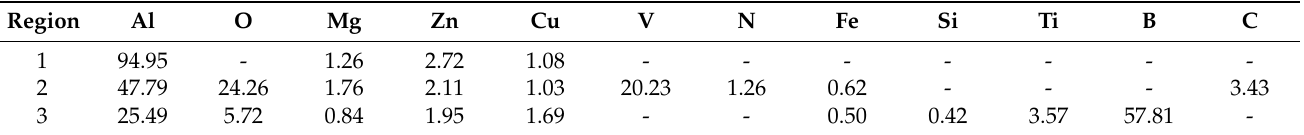
Table 3. EDS results (wt.%) in regions 1–3 indicated in Figure 5.